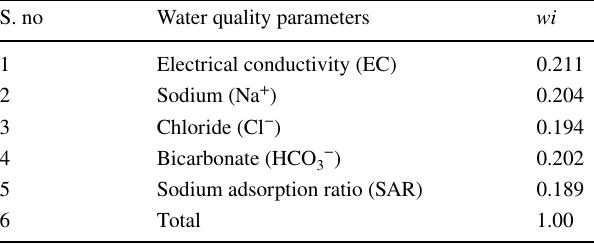
Table 4 Weights for the IWQI parameters (Meireles et al. 2010) S. no